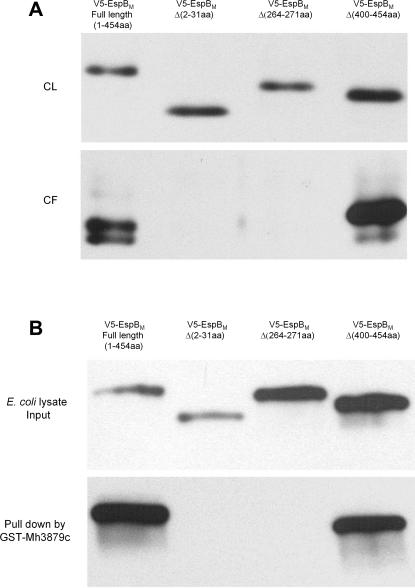
Deletion Analysis of EspBM Secretion and Interaction with Mh3879c(A) The M. marinum espBM::tn mutant was transformed with a non-integrating plasmid expressing N-terminally V5-tagged EspBM full length, EspBM Δ(2–31), EspBM Δ(264–271), or EspBM Δ(400–454). Cell lysates (CL) and culture filtrates (CF) were prepared from the indicated strains as described in Materials and Methods. The samples of each strain are normalized by OD readings. Of the total CL and CF fractions collected for each strain from one experiment, 3% of the CL was loaded in each lane and 15% of the total CF was loaded into each lane, separated by SDS-PAGE and detected by western blotting with an antibody against V5.(B) Agarose beads with immobilized GST-Mh3879c were incubated with E. coli lysates expressing V5-tagged EspBM full length, EspBM Δ(2–31), EspBM Δ(264–271), or EspBM Δ(400–454). The input lysate (0.1%) and the material from the cell lysates that bound to the beads was run on SDS-PAGE and detected by western blotting with an antibody against V5.